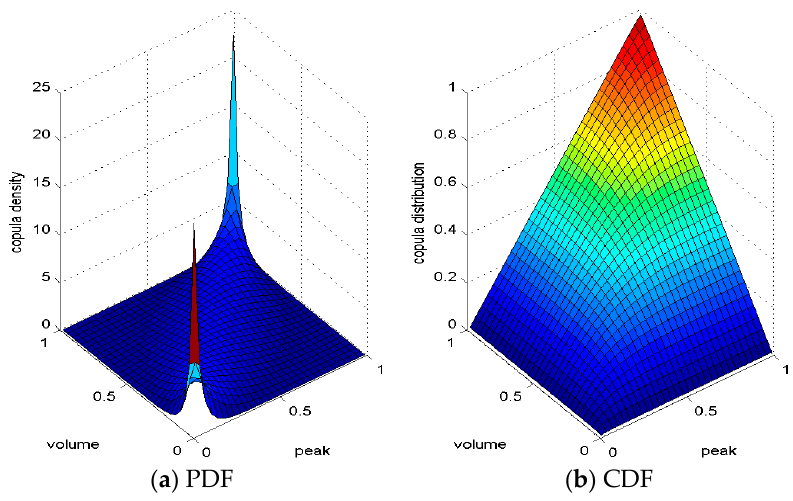
Figure 7. Peak-volume bivariate probability based on Clayton copula.